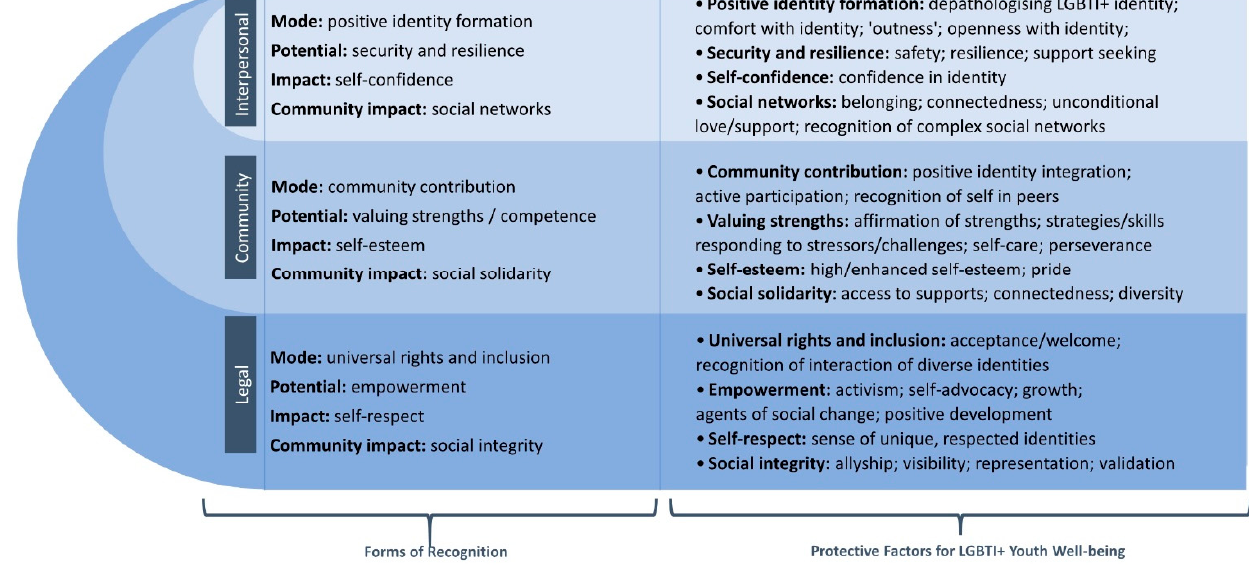
Figure 8. Mapping protective factors for LGBTI+ youth wellbeing onto Honneth’s Recognition Theory.